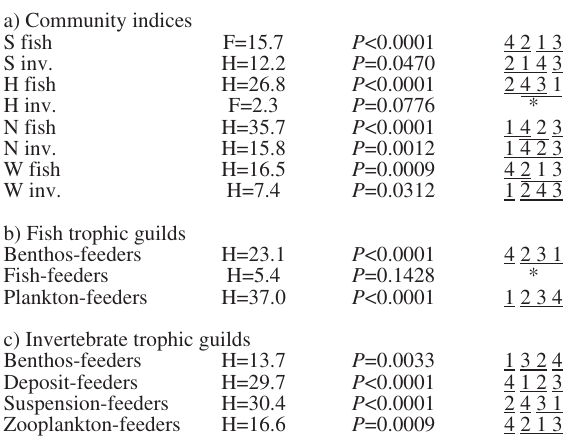
Table 5. – Significance tests between cluster groups for a) commu-5. – Significance tests between cluster groups for a) commu-. – Significance tests between cluster groups for a) commu- nity indices (S: species richness; H: Shannon diversity, N: density; W: biomass, of fish and invertebrates), b) trophic guilds of fish, and c) trophic guilds of invertebrates. 1, SST; 2, USW; 3, USE; 4, MS.